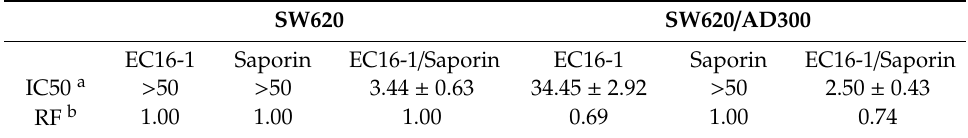
Table 1. Effect of EC16-1/saporin on the cellular proliferation of SW620 and SW620/AD300 cells . Table 1. E ff ect of EC16-1 / saporin on the cellular proliferation of SW620 and SW620 / AD300 cells. SW620